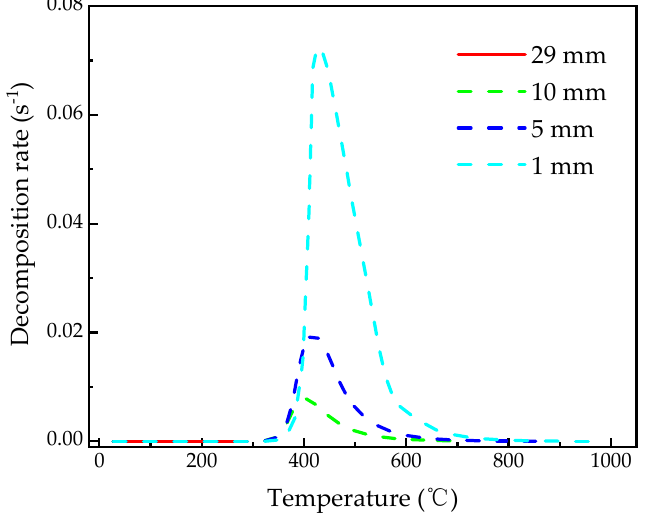
Figure 11. The change of decomposition rate with temperature for different positions of the glass fiber/phenolic resin composites.